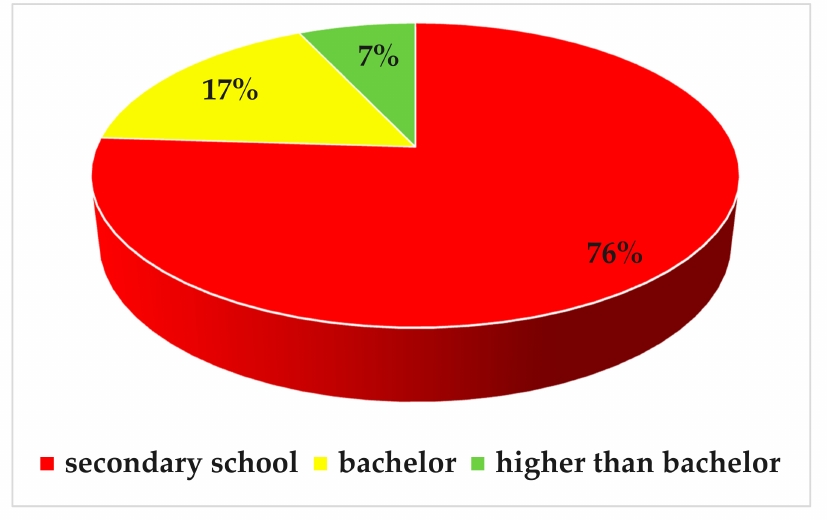
Figure 6. Characteristics of respondents based on